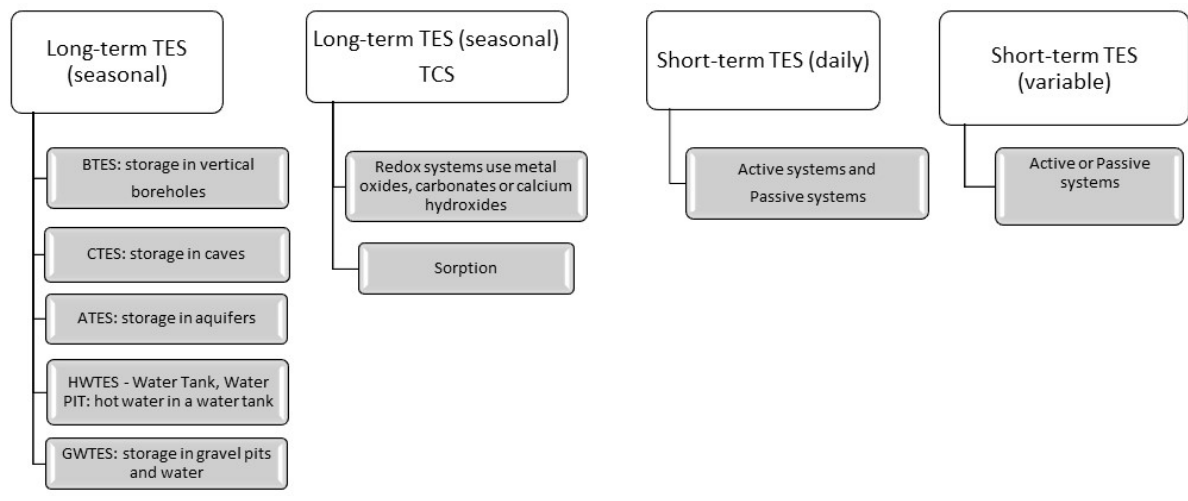
Figure 1. TES grouped based on the storage time